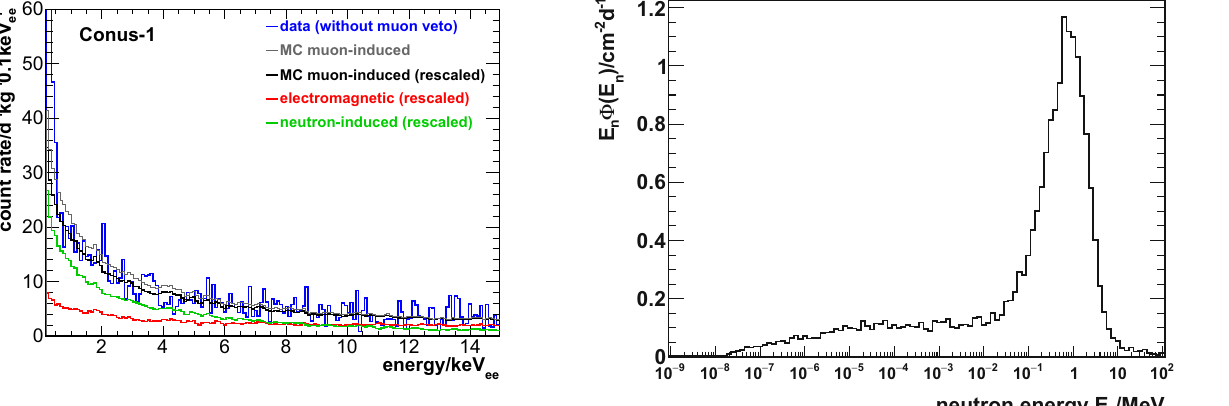
Fig. 8 Comparison of MC of μ -induced signals to lowE data of C1 without applied μ -veto (corrected for other non- μ -induced back- ground). A good agreement is observed. The red spectrum corresponds to the electromagnetic contribution; the green spectrum relates to the neutron-induced background. By minor rescaling, the agreement can be improved Table 2 Comparison of MC simulation of the muon-induced back- ground to data collected without μ -veto for C1. Above 100keV, excel- lent agreement is achieved. For the background model, the lowE MC was rescaled to improve the agreement (see also Fig.8). All uncertain- ties on the simulated data are statistical Integral range Meas. data